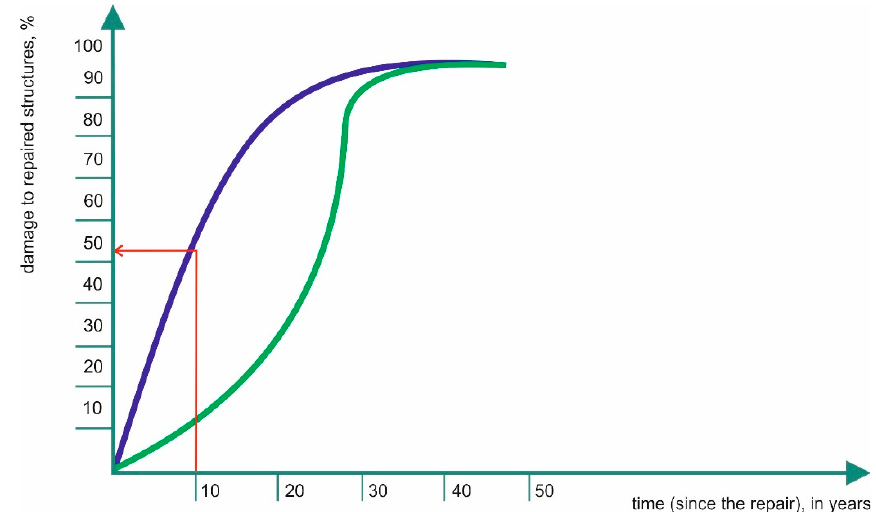
Figure 9. Damage to the repaired structures (repair durability) incrementally in time (navy line); data according to [20]. The green line stands for the simulated distribution for repairs made according to EN 1504 ‐ 1 ÷ 10.